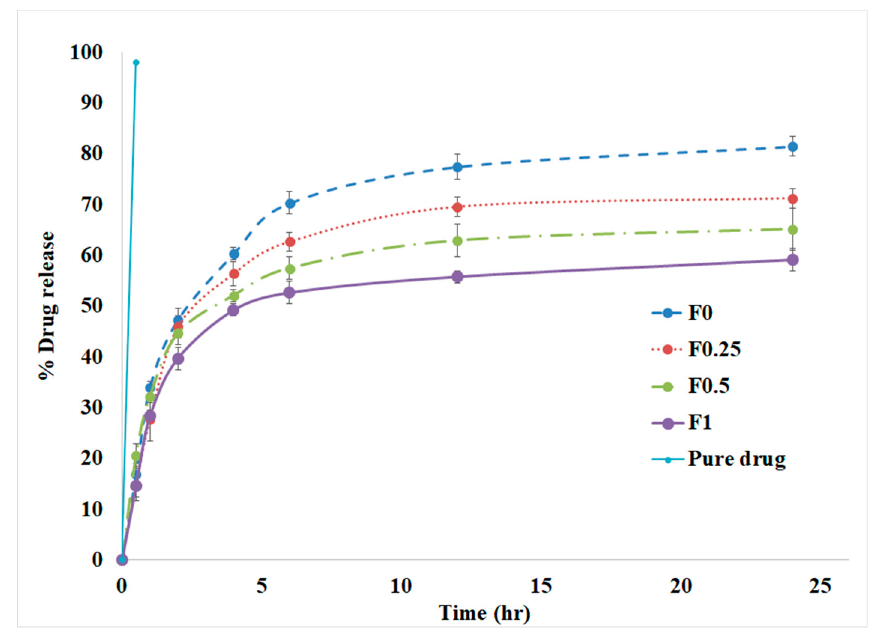
Figure 5. Cumulative release profiles of tobramycin-loaded PLGA and LMWC-PLGA NPs in phosphate-buffered saline (pH = 7.4) at 37 °C.